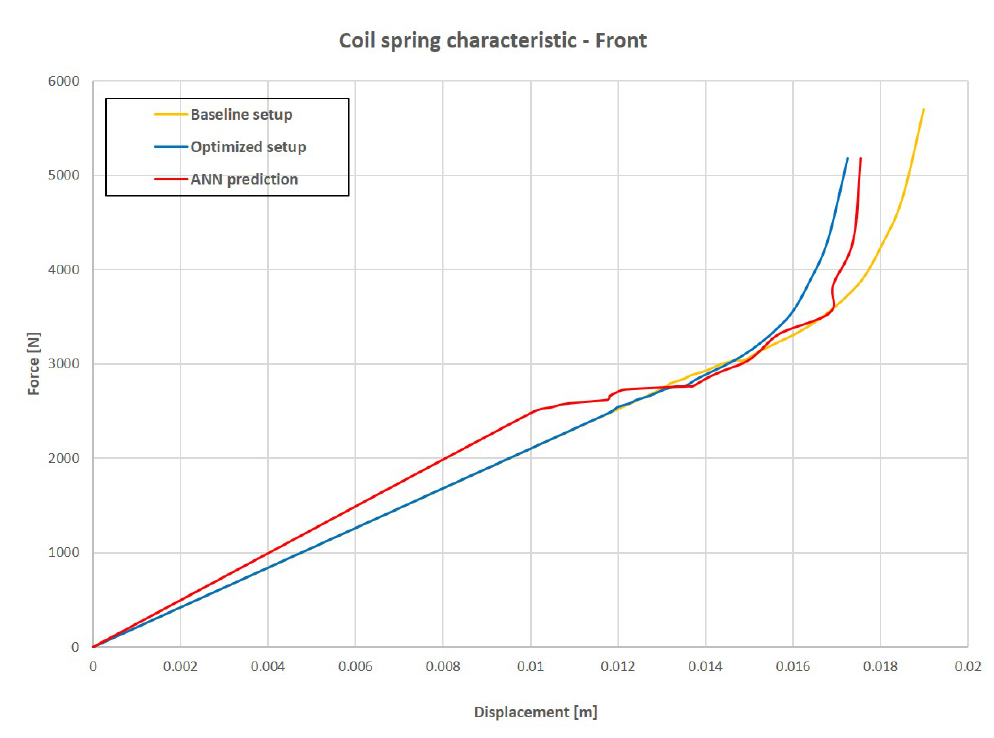
Figure 30. Rear roll center variation comparison.